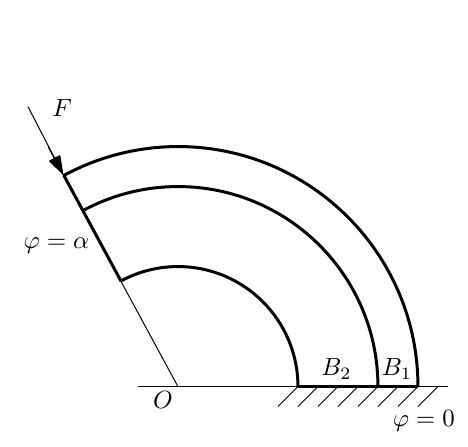
Figure 20: Two-layer composite beam with concentrated radial